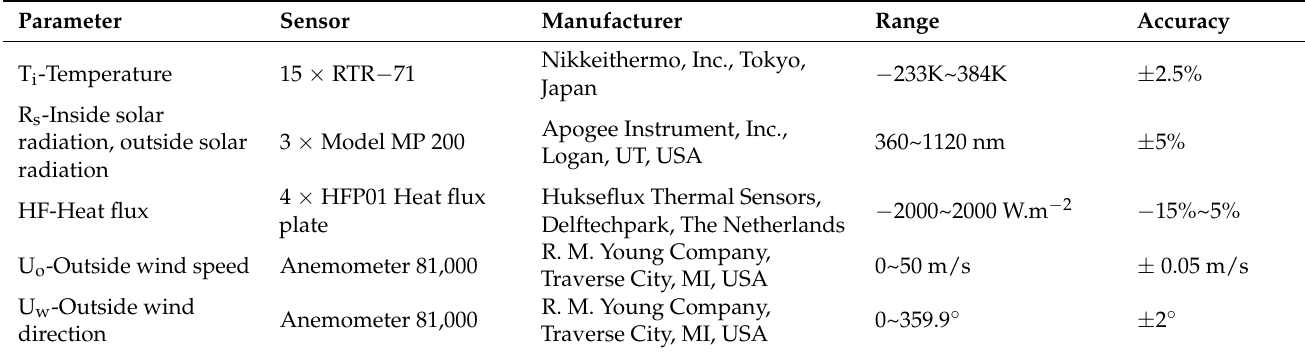
Table 1. Technical characteristics of sensors used to measure climate parameters.